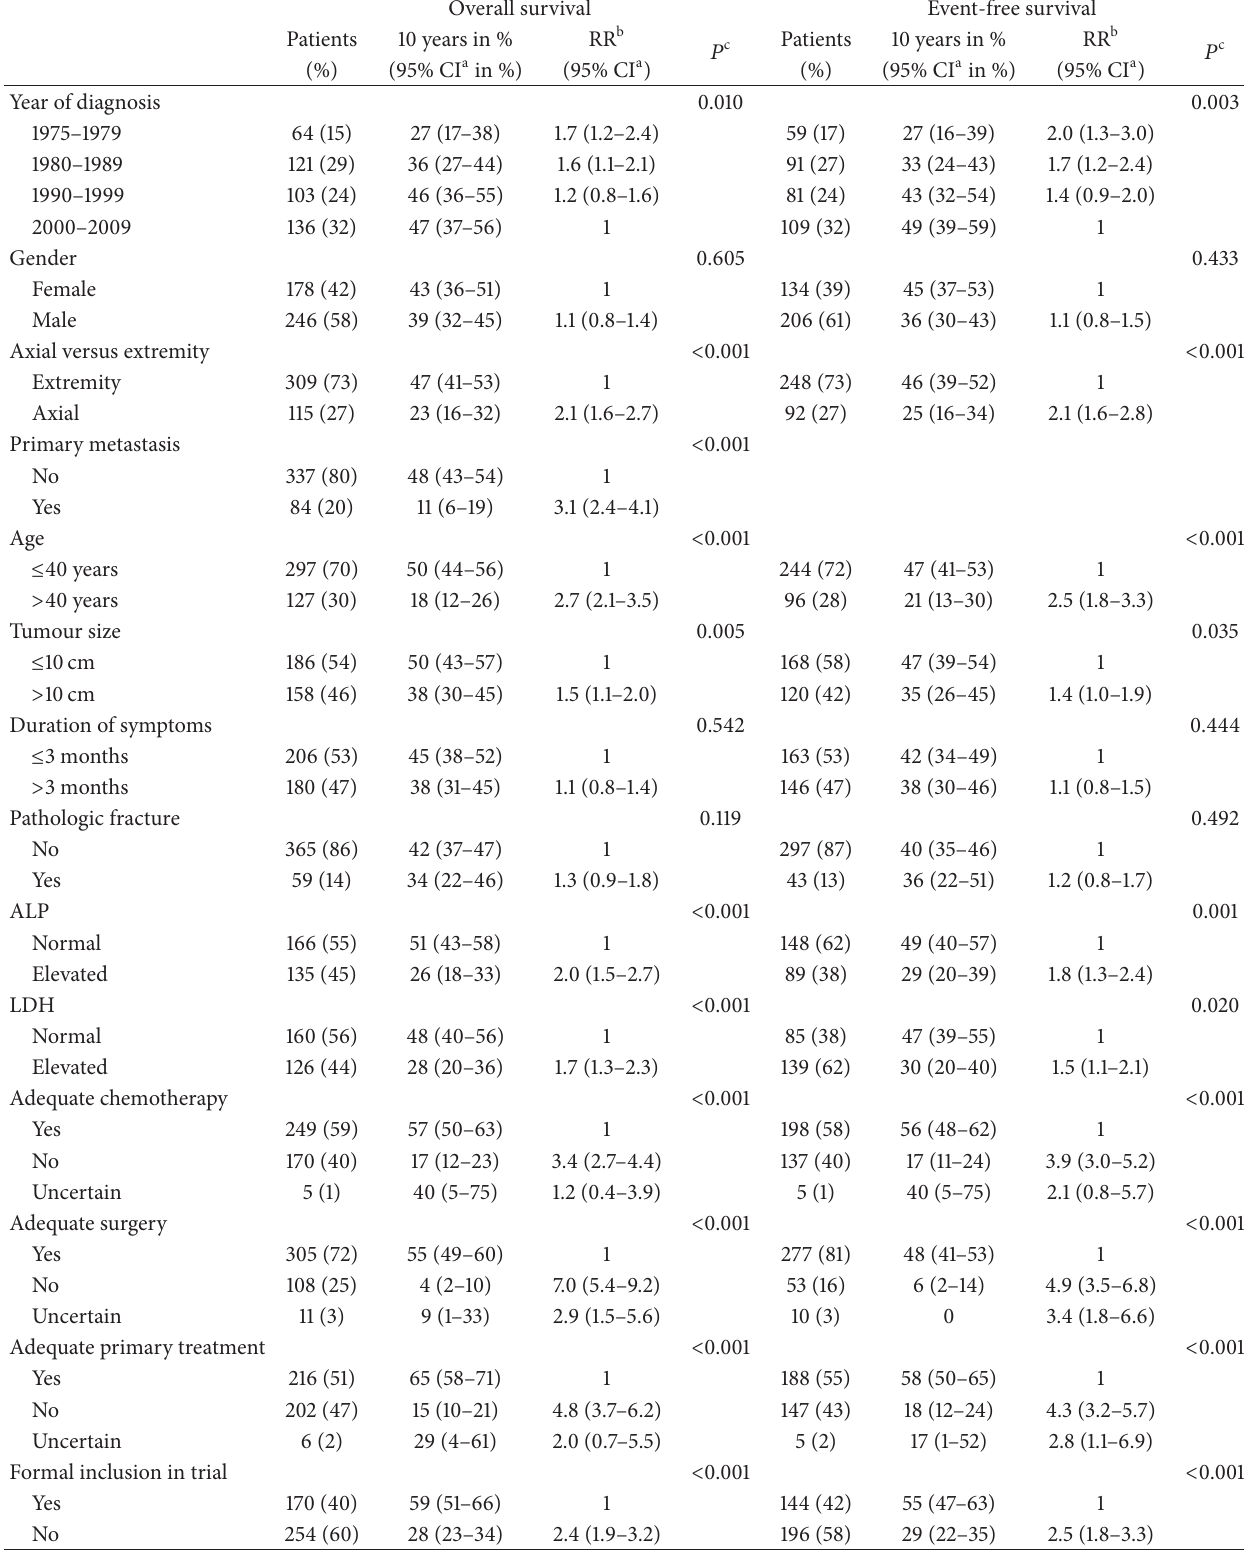
Table 4: Univariate Kaplan-Meier and Cox-regression analysis of ten-year overall survival and event-free survival according to different characteristics of all high-grade